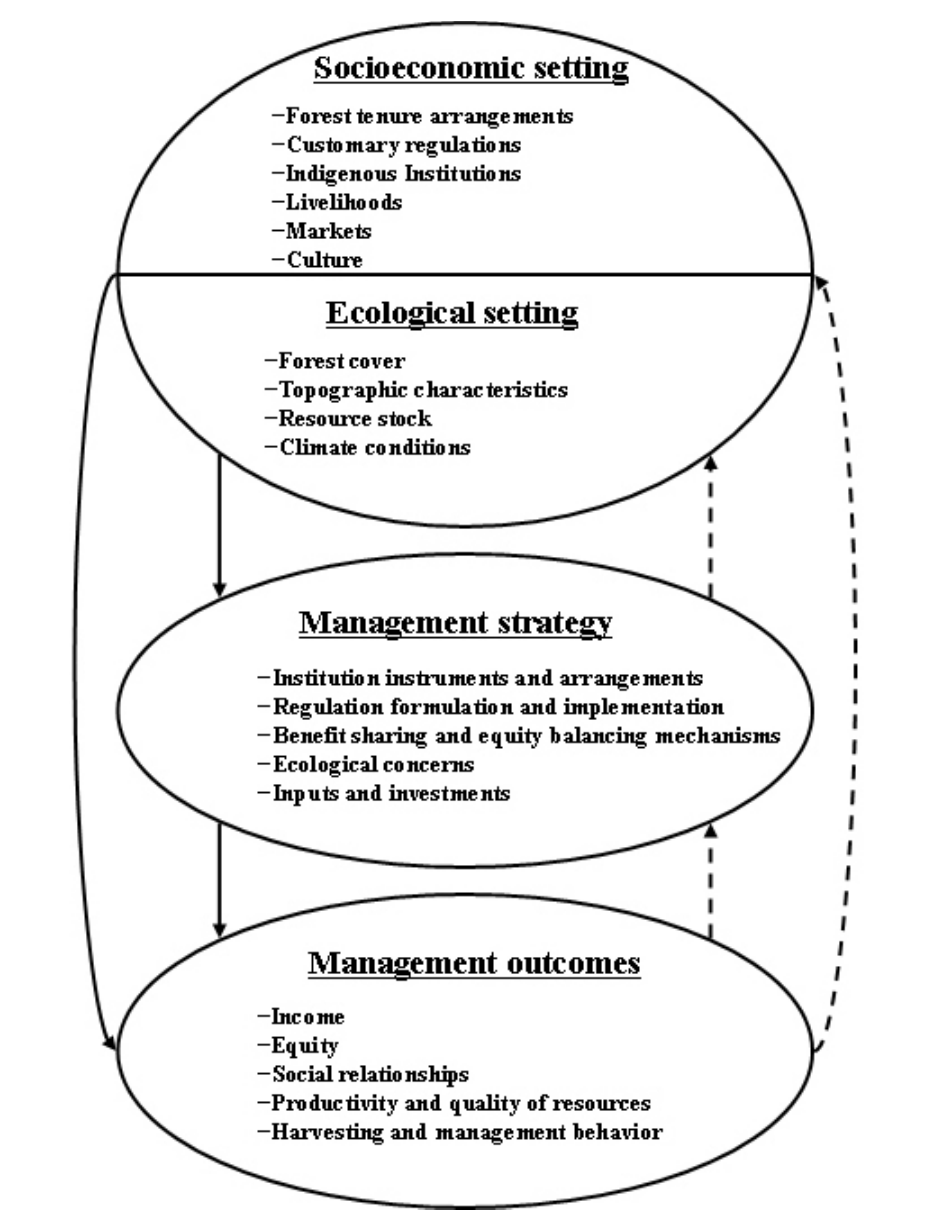
Fig. 1. Analytical framework of the